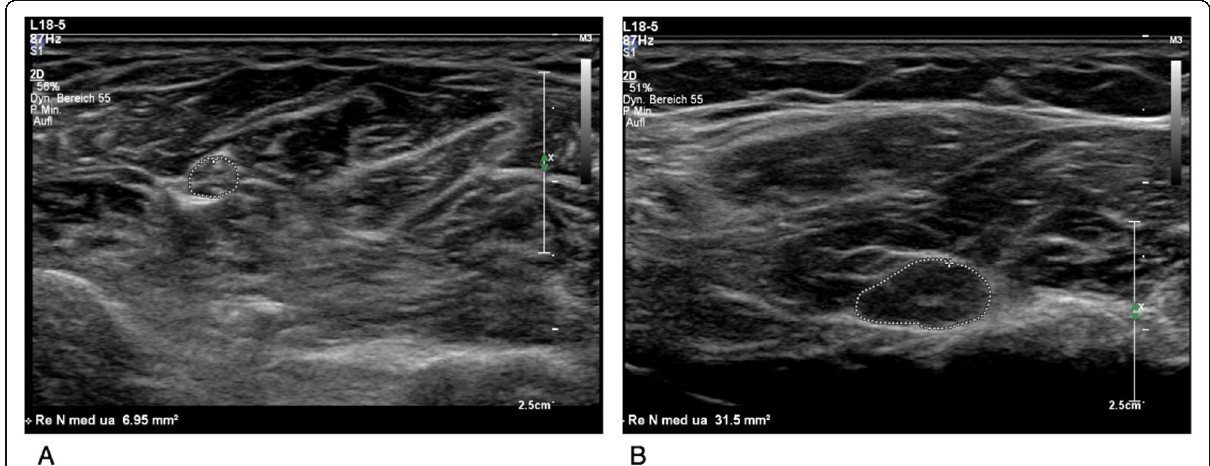
Fig. 2 a Normal median nerve at the middle of the forearm between the flexor digitorum profundus and superficialis muscles with a normal CSA of 6.95 mm 2 and normal fascicular structure. b Significantly enlarged median nerve at the forearm with a CSA of 31.5 mm 2 in a patient with CIDP. Some swollen fascicles and a hypoechoic structure can be depicted. Ultrasound stetting except focus are the same in both